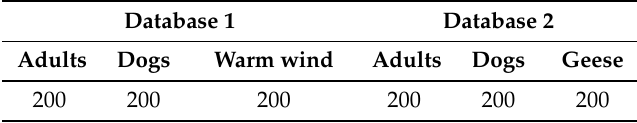
Table 1. Construction of human and nonhuman PIR signal database.